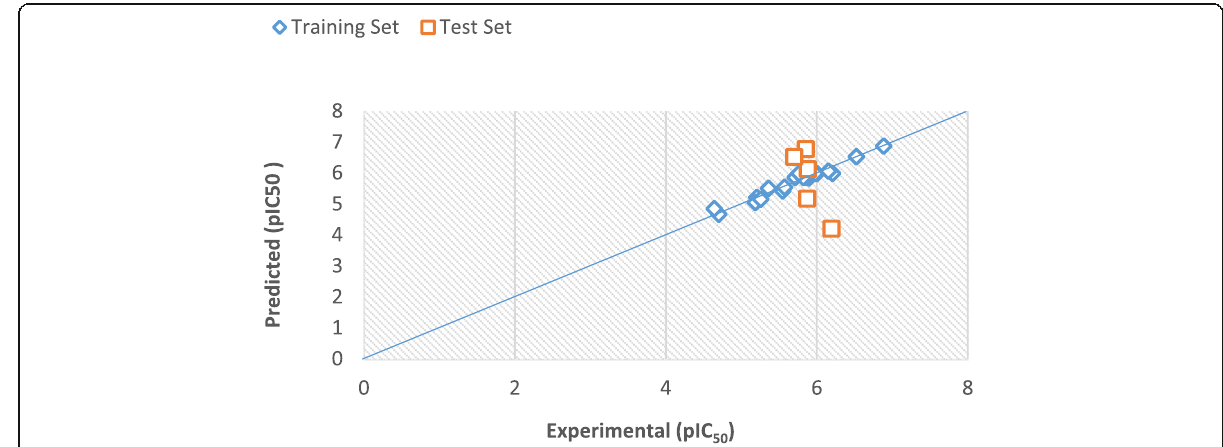
Fig. 4 The plot of experimental against predicted values of biological activities expressed as (pIC 50 ) of phthalazinone